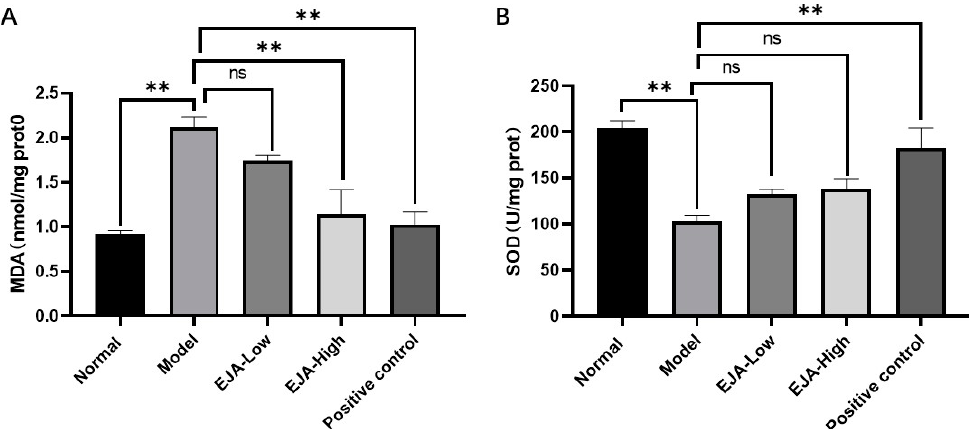
Figure 3. A. japonica alleviates the level of oxidative stress induced by acute liver injury. ( A ) MDA levels in rat liver tissues; ( B ) SOD activity in rat liver tissues, Student’s t-test was performed (ns: not significant, ** p < 0.01).